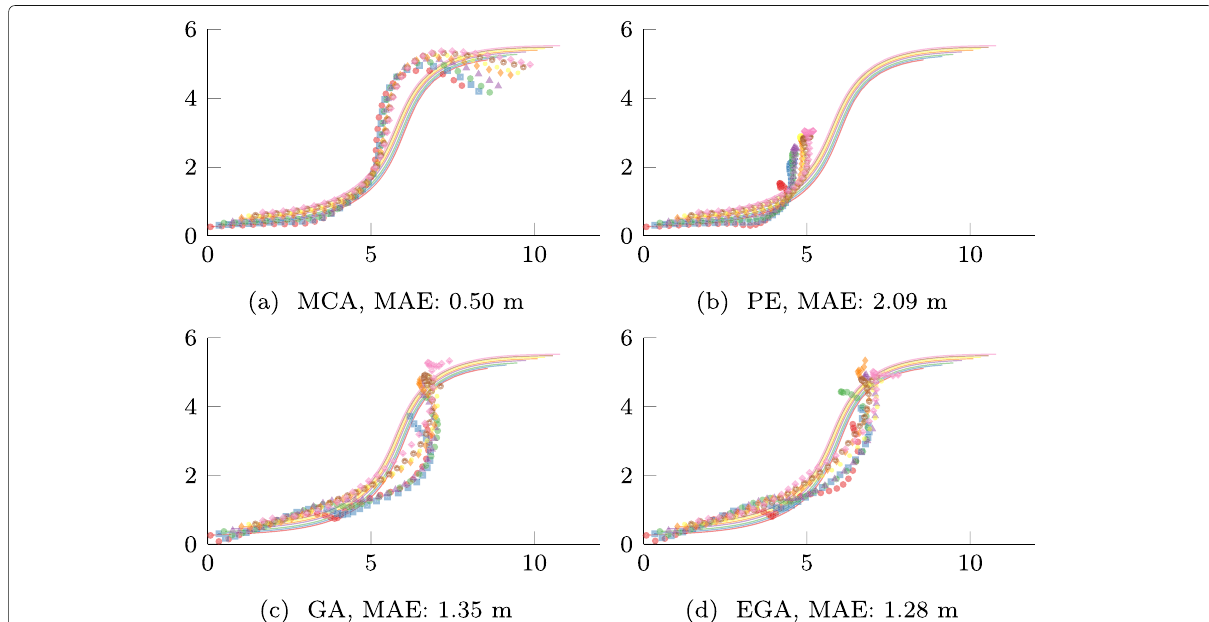
Fig. 14 Average estimated positions (markers) and actual trajectories (solid lines) in the case of M = 8 agents and for 1500 PPA. a MCA, MAE 0.50 m. b PE, MAE 2.09 m. c GA, MAE 1.35 m. d EGA, MAE 1.28